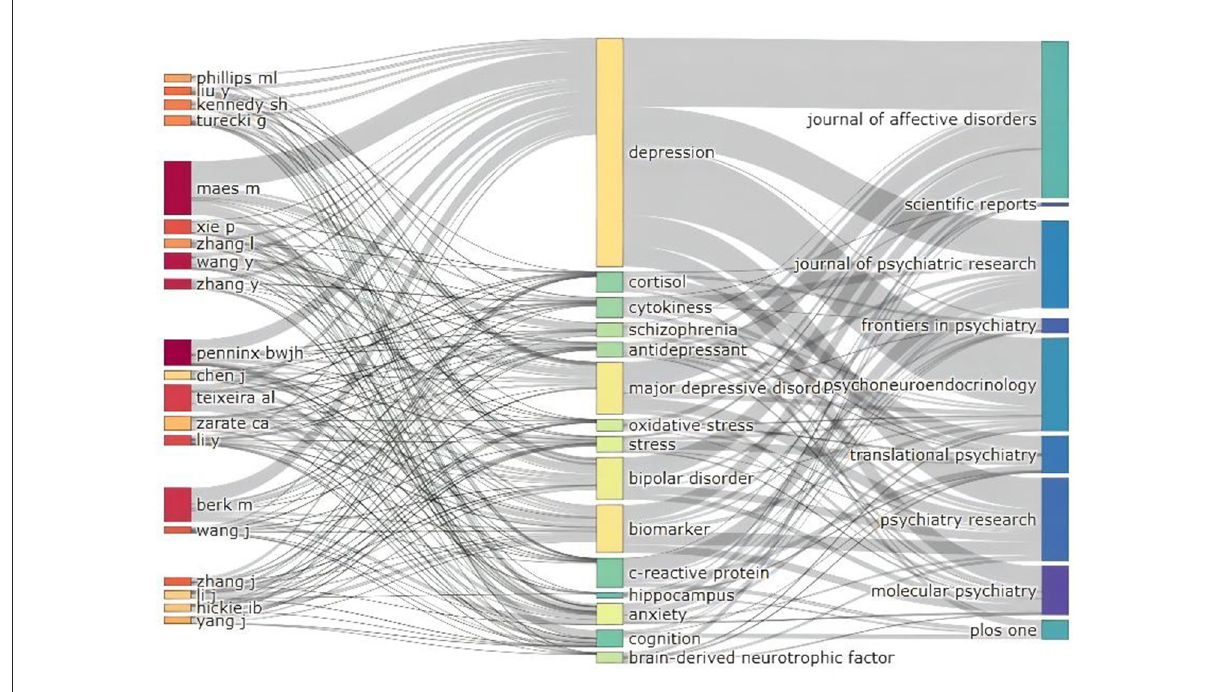
FIGURE3 Three-field plot of active institutions and authors publishing articles related to depression biomarkers between 2009 and